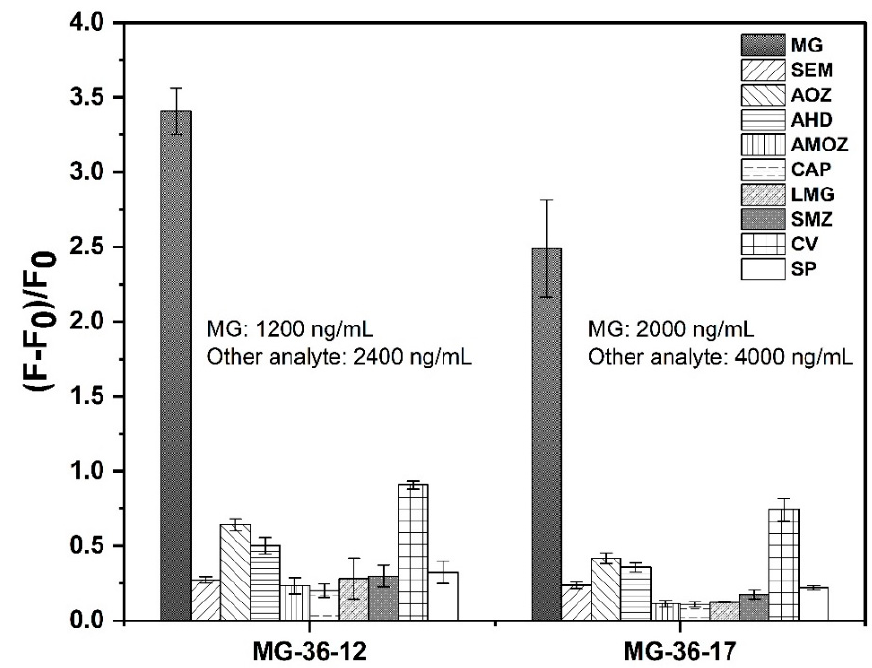
Figure 6. Fluorescence results were obtained in the presence of MG and the different analytes samples. The ratio of (F − F 0 )/F 0 was calculated to show the relative fluorescence intensity of aptamer.